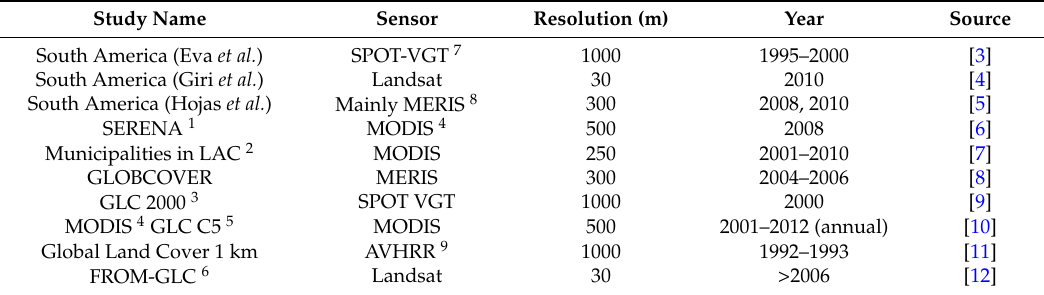
Table 1. Global and continental land cover maps for Colombia derived from satellite